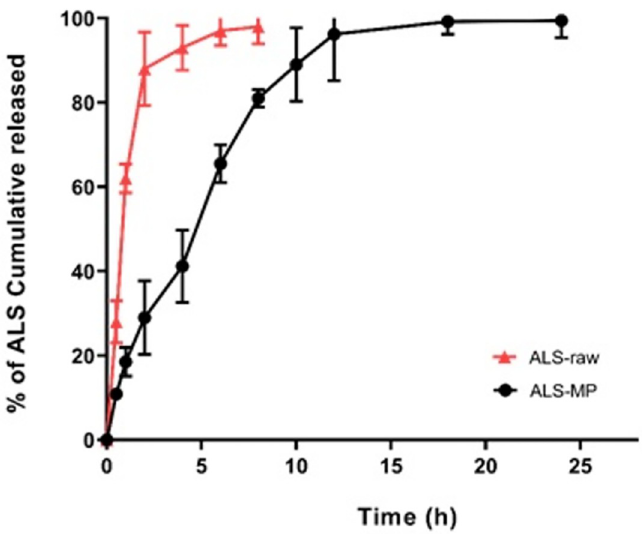
Fig 3. The in vitro release pattern of drug from optimized ALS-MP and ALS-raw.